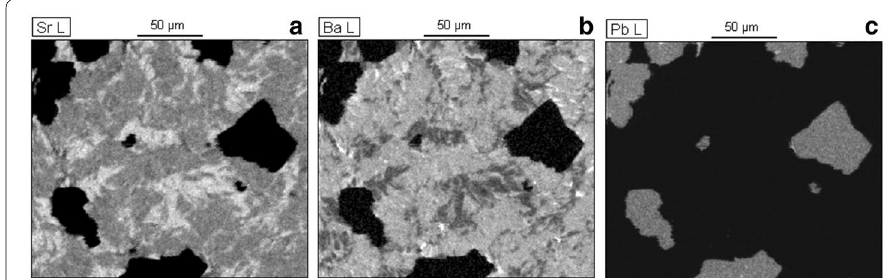
Fig. 2 SEM–EDX element maps of the cut and polished sample cross-section. a The distribution of Sr in